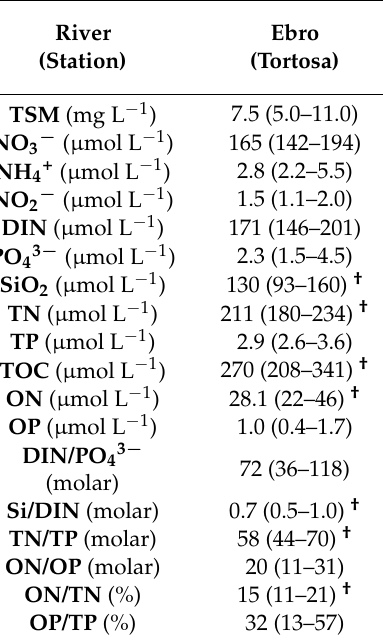
Table 3. Concentration (median, 1st–3rd quartile) of TSM (mg L − 1 ), nutrients and organic